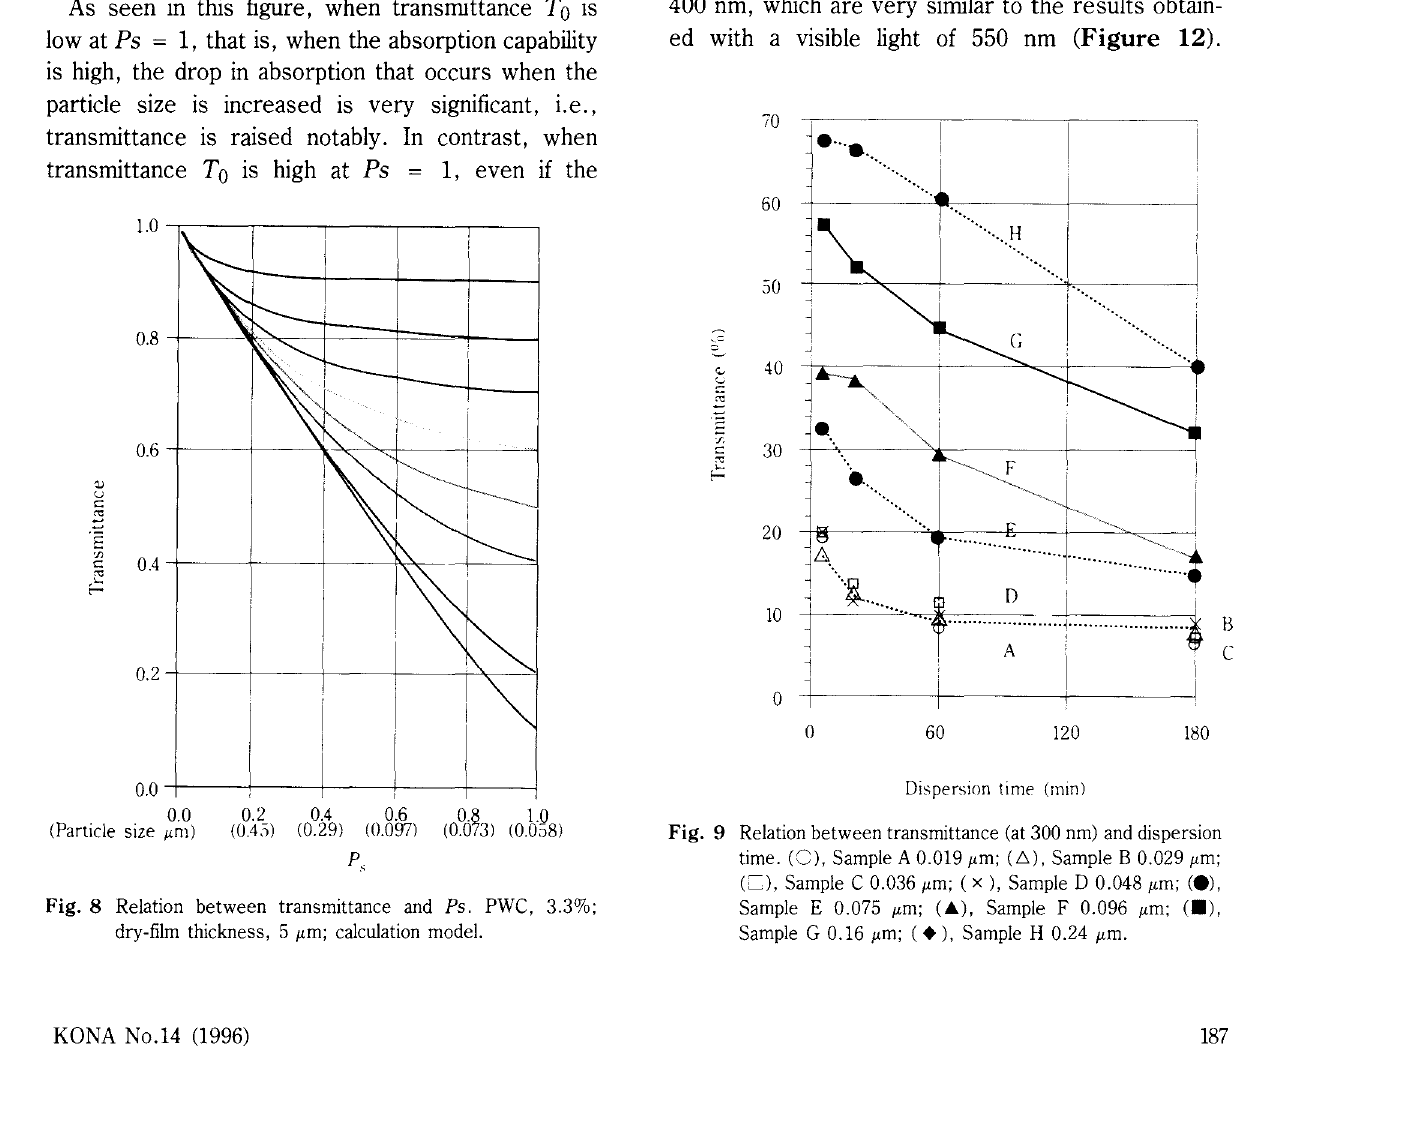
Fig. 9 Relation between transmittance (at 300 nm) and dispersion time. (C), Sample A 0.0191'm; (6), Sample B 0.0291'm; (L), Sample C 0.036 I'm; ( x ), SampleD 0.0481'm; (e), Sample E 0.075 I'm; (&), Sample F 0.096 I'm; (•). Sample G 0.16 I'm; (+),Sample H 0.24